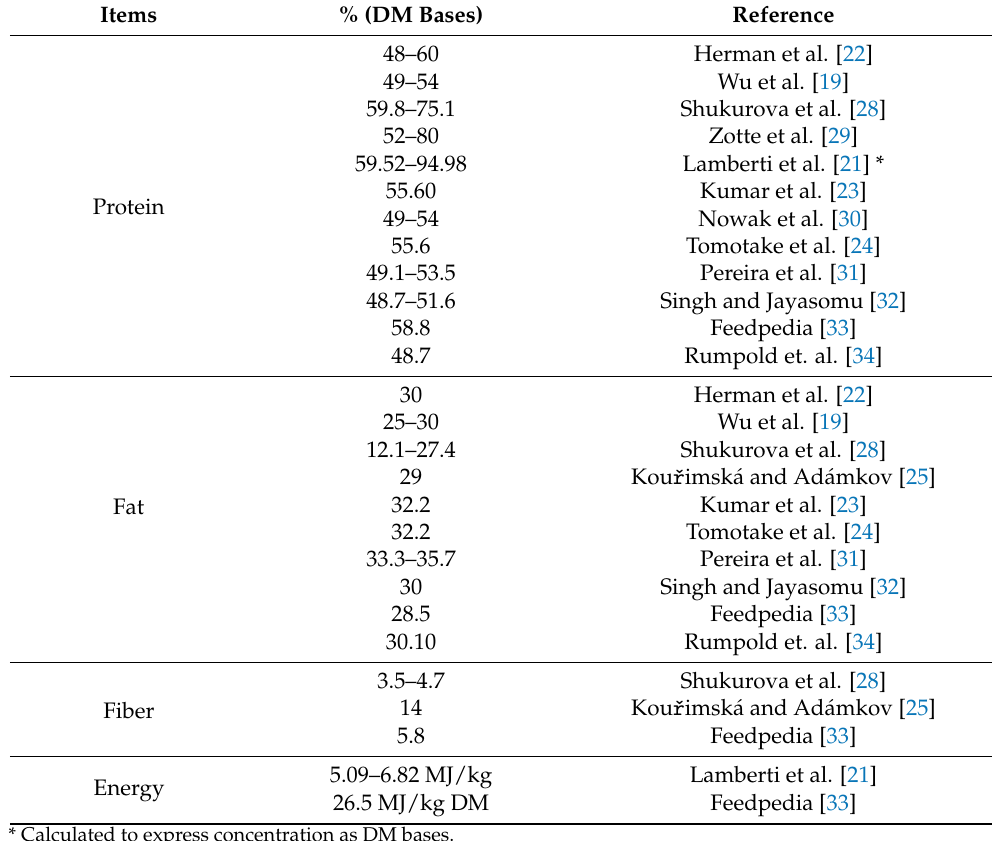
Table 1. Nutritional composition of silkworm pupae ( B. mori ).